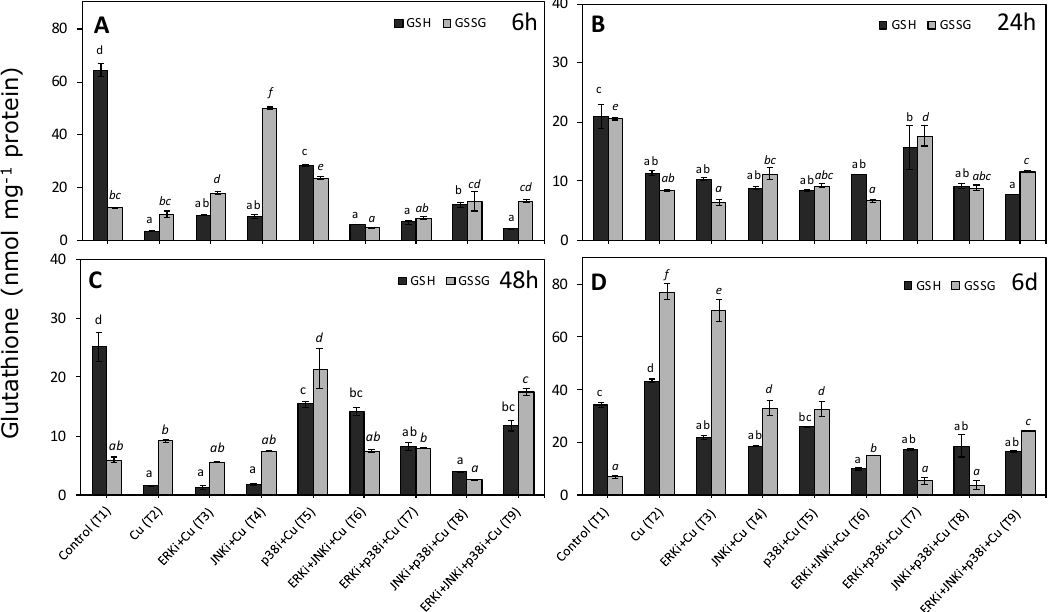
Figure 3. Total reduced (GSH) and oxidised glutathione (GSSG) content in U. compressa under copper and/or exposure to MAPK inhibitors. Treatments consisted in: T1) control only with seawater; T2) Solely copper exposure as 10 µM CuSO 4 (Cu); T3) copper + 5 µM MAPK ERK inhibitor PD98059 (Cu + ERKi); T4) copper + 5 µ M MAPK JNK inhibitor SP600125 (Cu + JNKi); T5) copper + MAPK p38 inhibitor SB203580 (Cu + p38i); T6) Cu + ERKi + JNKi; T7) Cu + ERKi + p38i; T8) Cu + p38i + JNKi; and T9) Cu + ERKi + JNKi + p38i. Samples were analysed after 6 h ( A ), 24 h ( B ), 48 h ( C ), and 6 d ( D ) treatments. Different letters represent significant difference at 95% confidence interval ( p < 0.05). Plots are represented as mean ± SE ( n =